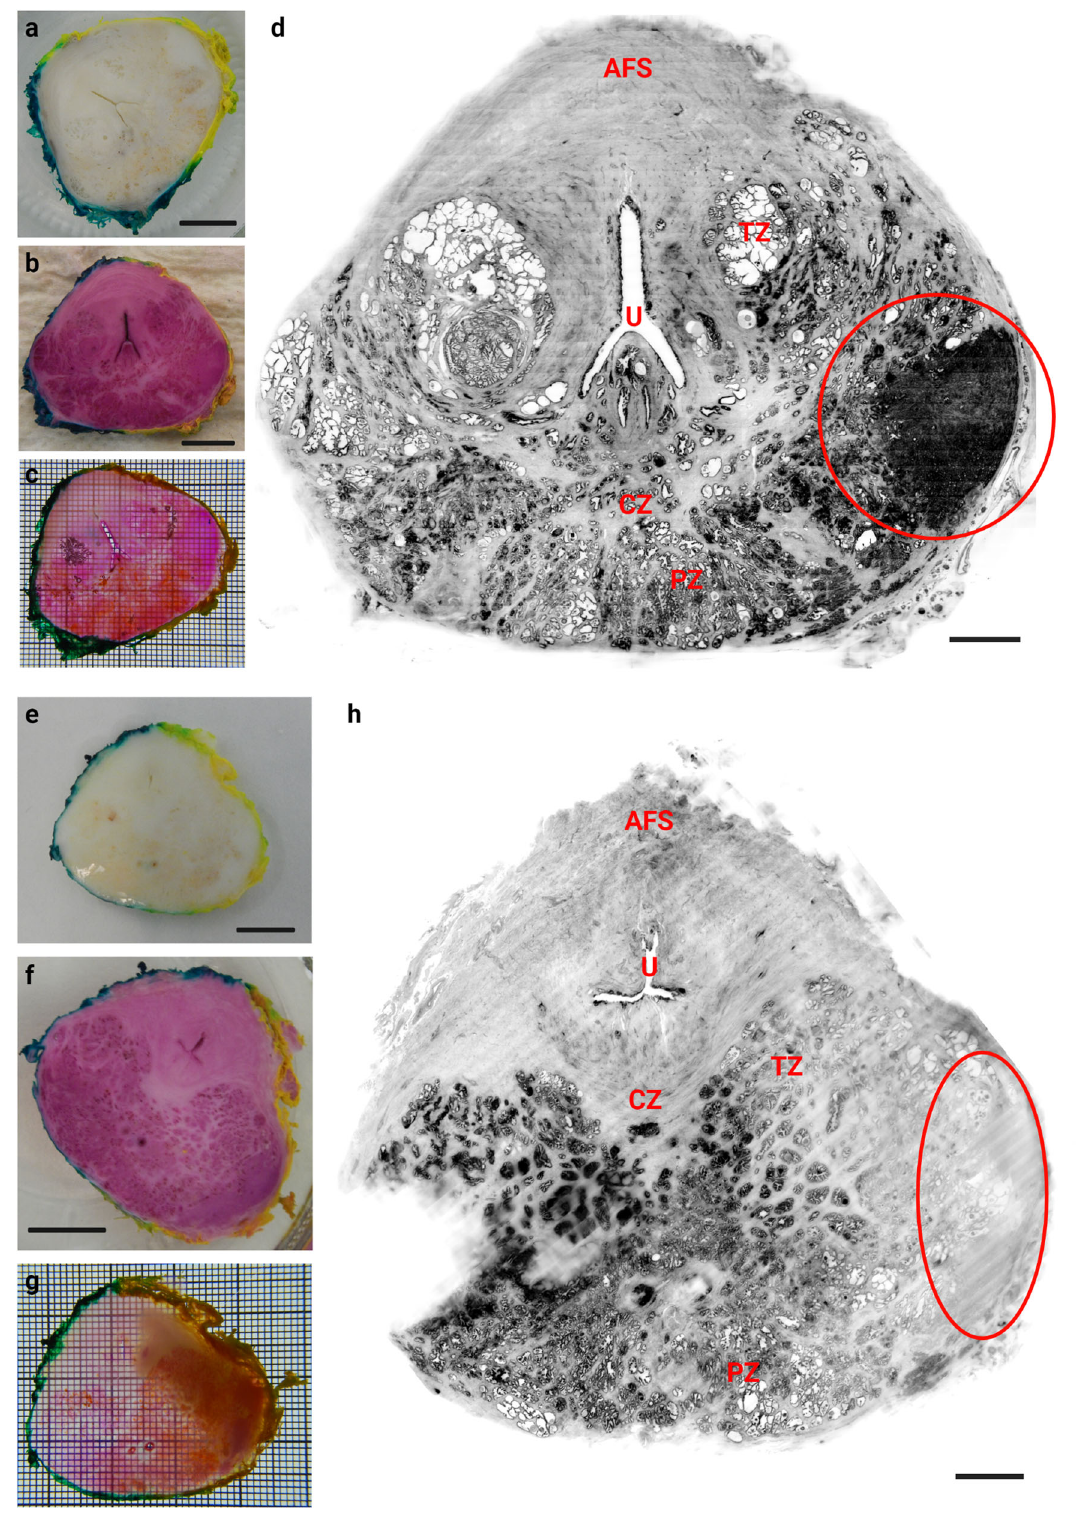
Fig. 6 Two prostate cancer samples cleared and labelled with MASH and imaged with ct-dSPIM Mosaic 16. Sample are shown at various stages during the processing pipeline on the left side: After deparaf fi nisation and bleaching ( a , e ), after staining ( b , f ), and after RI-matching (i.e., cleared, c , g ). On the right side, a MIPs from the Mosaic 16 data set over approx. 50 µ m are shown in inverted greyscale ( d , h ). The red circles indicate the cancerous regions (as identi fi ed by a pathologist). Abbreviations: AFS anterior fi bromuscular stroma, CZ central zone, U (prostatic) urethra, PZ peripheral zone, TZ transition zone. Scale bars: 3